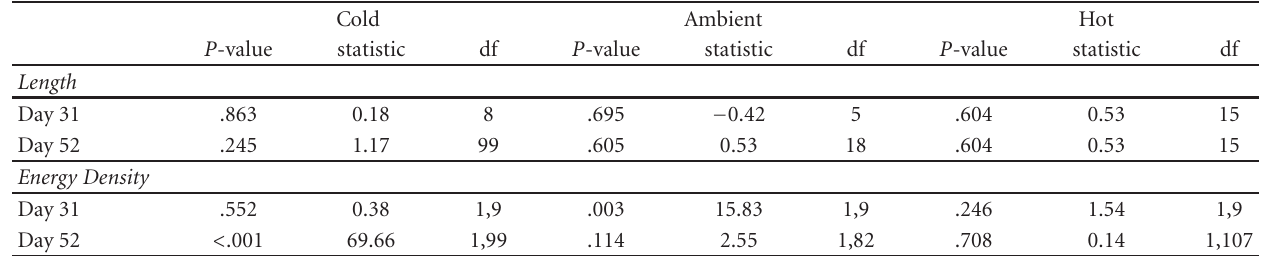
Table 2: Test statistics for comparisons of infected versus uninfected juvenile Pacific herring lengths and energy densities at di ff erent water temperatures. Length comparisons were 2-sample t -tests ( T statistic reported), while energy density comparisons were GLM ANOVAs ( F statistic